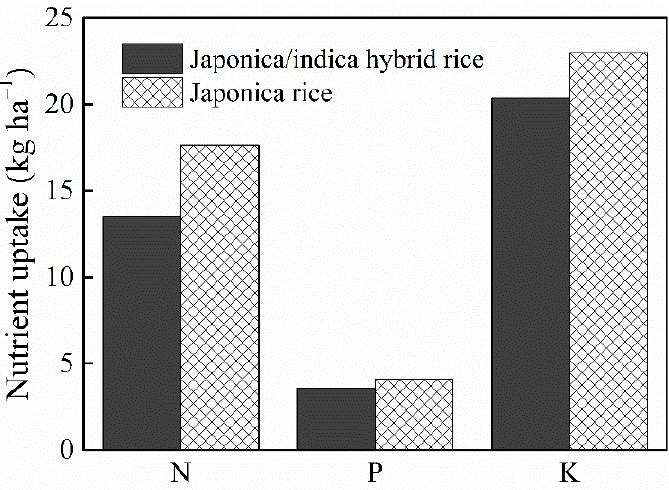
Figure 5. The nutrient requirements of japonica/indica hybrid rice and japonica rice in above-